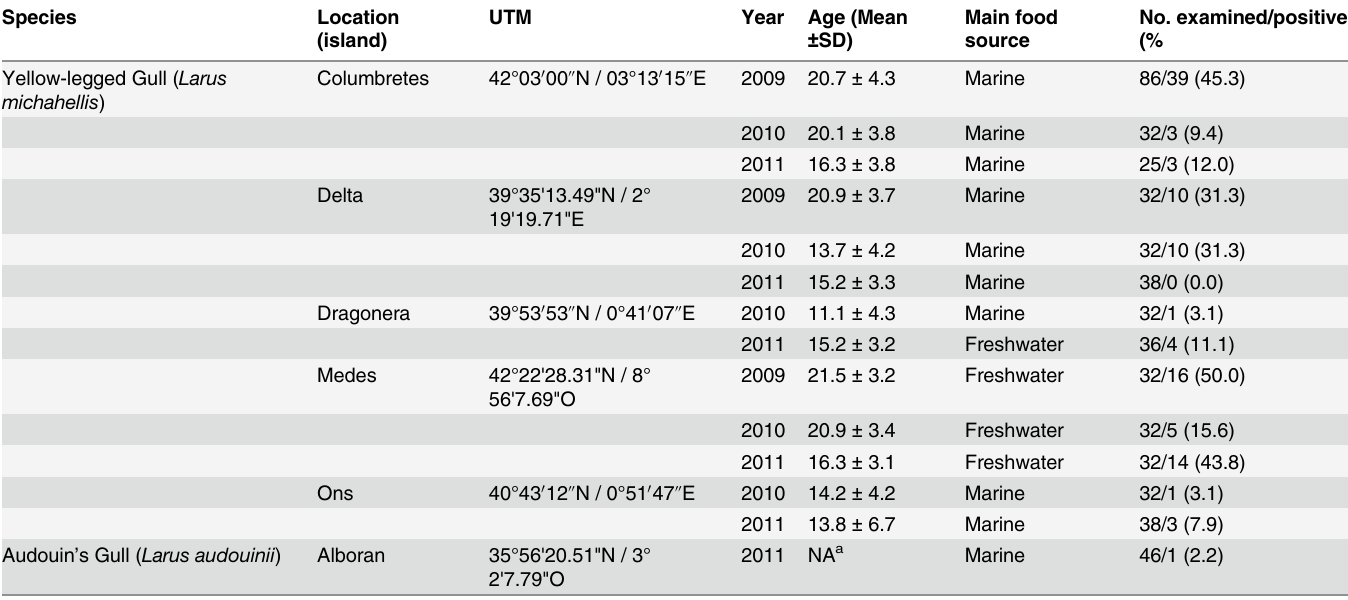
Table 1. Seroprevalence of Toxoplasma gondii in seagulls from Spain.